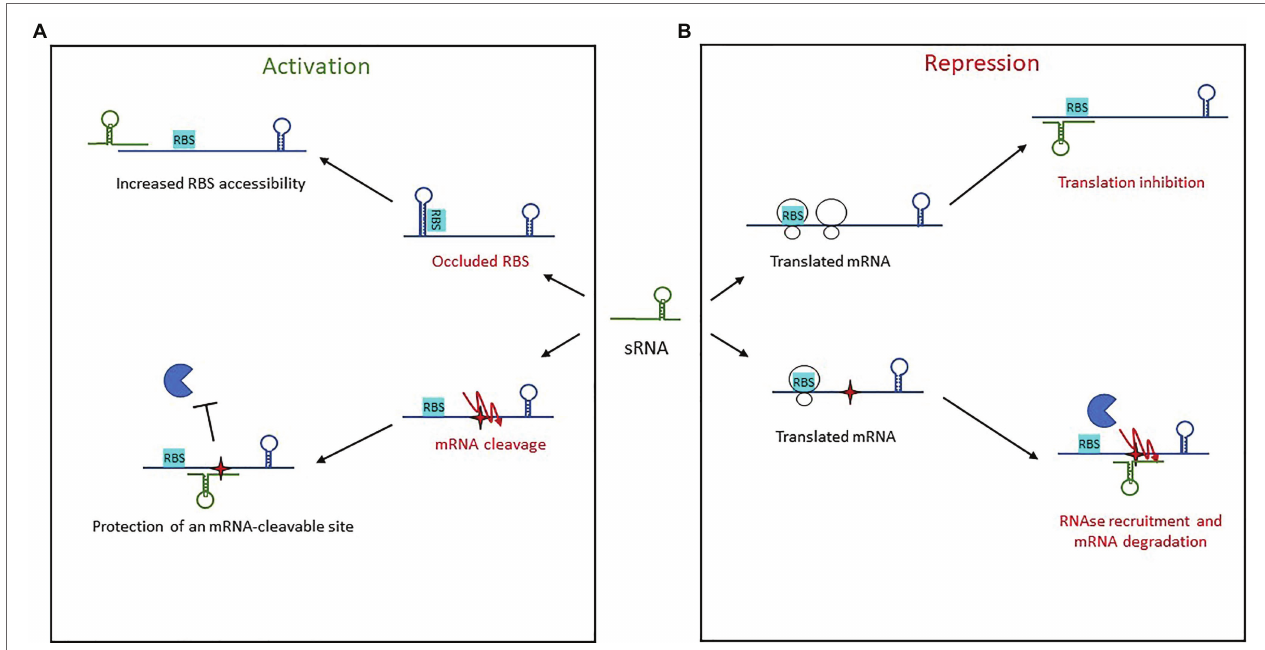
FIGURE 5 | Mechanisms of action used by trans -encoded sRNAs. (A) In post-transcriptional activation, sRNA binding of an mRNA target results in either increased RBS accessibility or protection of an mRNA-cleavable site. (B) Repression of gene expression by trans -encoded sRNAs occurs when the sRNA binds an mRNA target, resulting either in translation inhibition by preventing ribosome loading or else recruitment of an RNase for mRNA